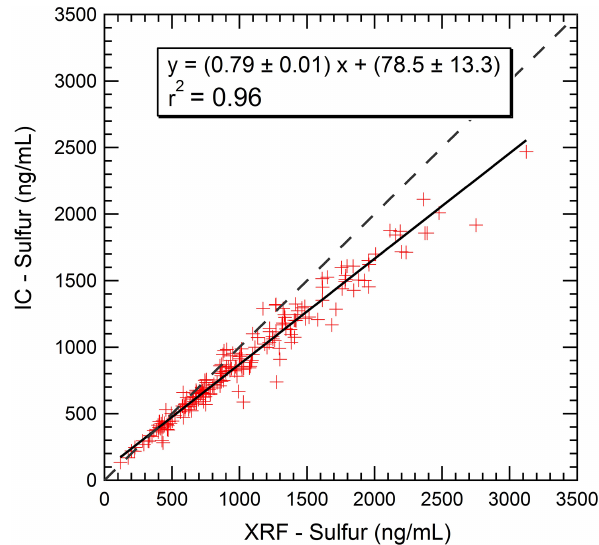
Figure 3. Sulfur measured by XRF and one-third of sulfate mea- sured by IC (results of orthogonal regression are shown, along with 1 : 1 ratio by dotted